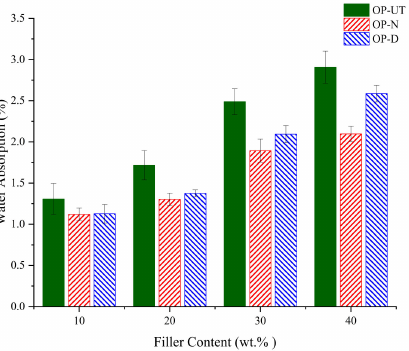
Figure 5. Water absorption of developed